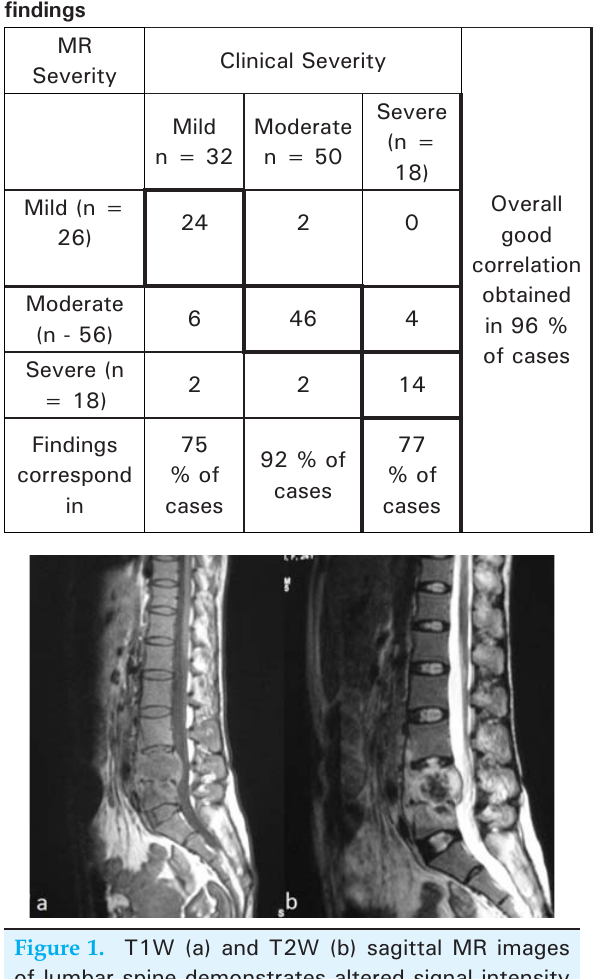
Table 2: MR signal intensity alteration in vertebrae and